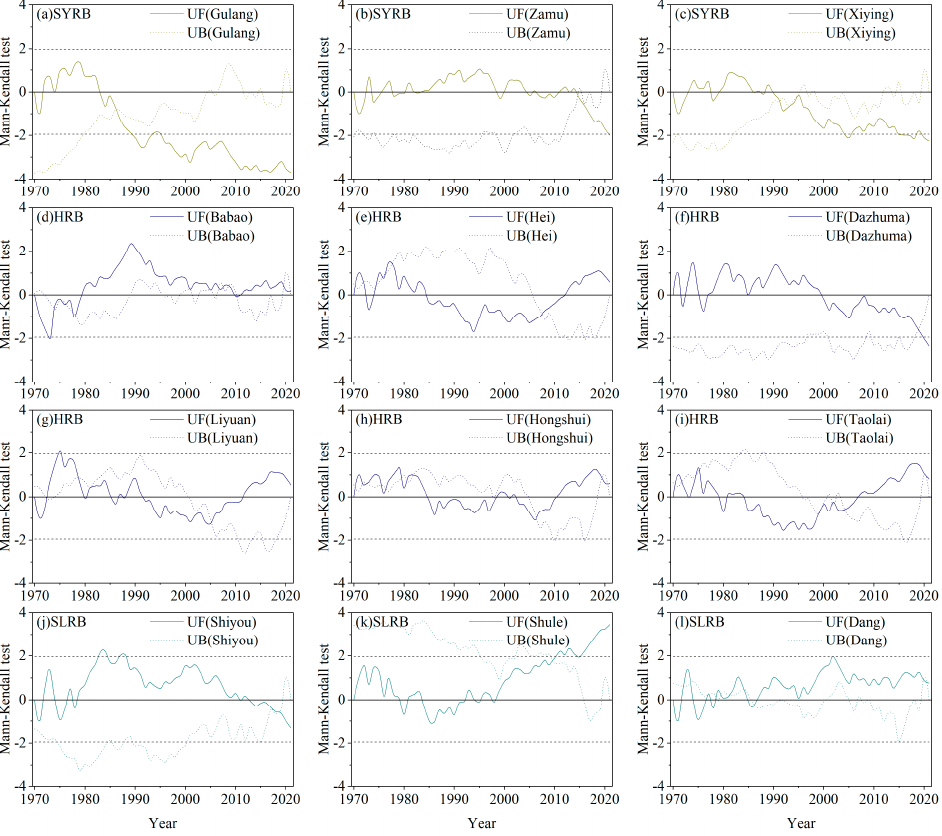
Figure 3. Trends of SQ–MK test in AMPD for 12 representative rivers in the QM region, northwest China. ( a − c ) Denote Gulang, Zamu, and Xiying rivers in SYRB, ( d − i ) denote Babao, Hei, Dazhuma, Liyuan, Hongshui, and Taolai rivers in HRB, ( j − l ) denote Shiyou, Shule, and Dang rivers in SLRB, respectively.